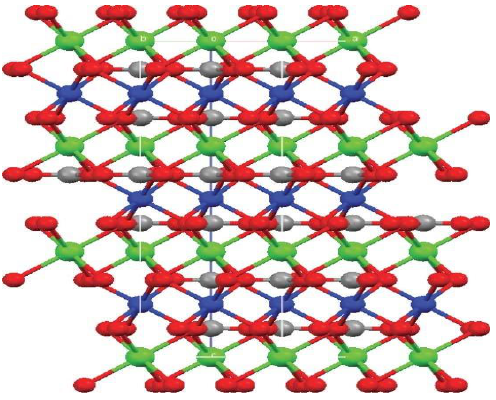
Figure 1. Structure of dolomite MgCa(CO 3 ) 2 C-grey, Mg 2+ -blue, Ca 2+ -green, O 2— red.